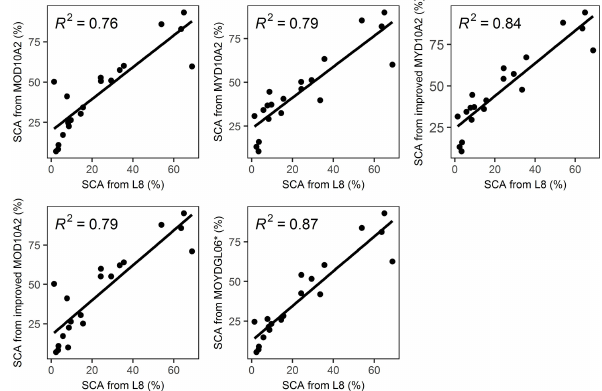
Figure 8. Correlation of the snow cover area (SCA) from origi- nal products, improved individual MOD10A2* and MYD10A2* C6 products, and MOYDGL06* data with the Landsat 8 (L8)